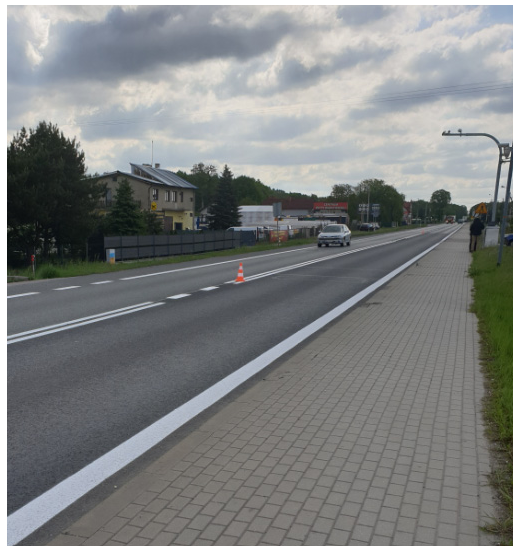
Figure 1. WIM station located on the DK44 road. Table 1. Location parameters.